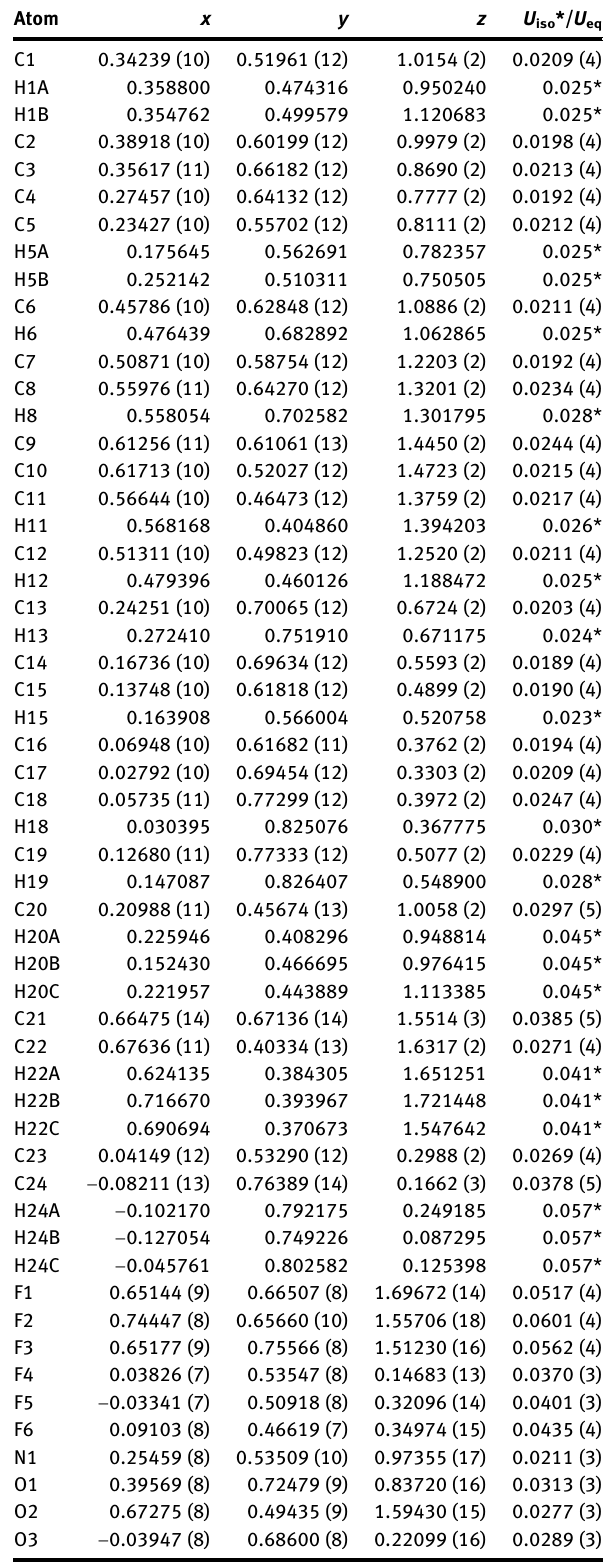
isotropic displacement parameters (Å 